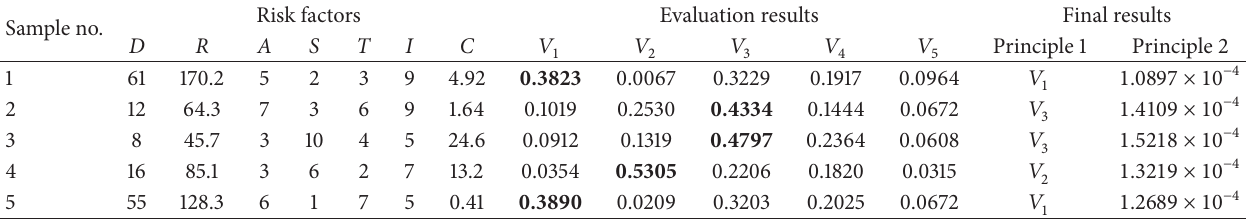
Table 12: Risk results of multilevel fuzzy comprehensive evaluation of the samples in case study. Sample